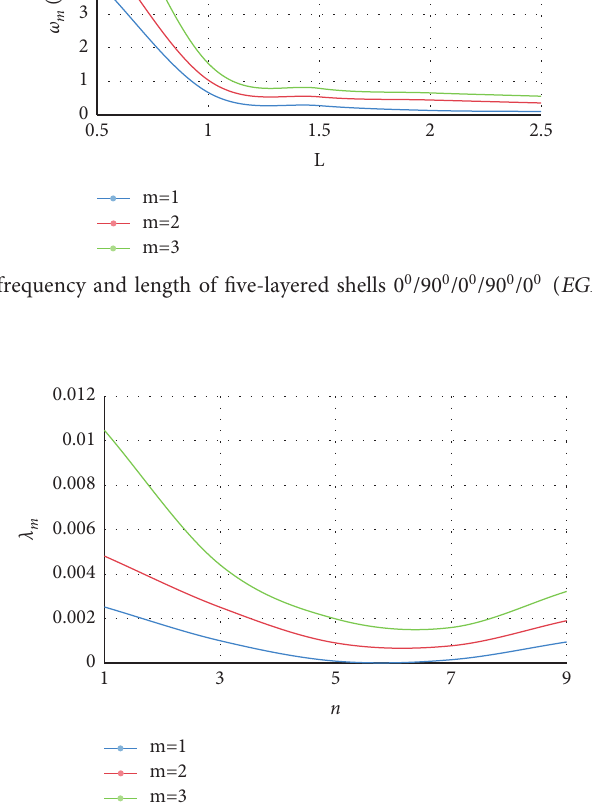
Figure 6: Relation between frequency and circumferential node number of three-layered shells 0 0 /90 0 /0 0 ( EGE / KE / EGE ) ; L � 0 .